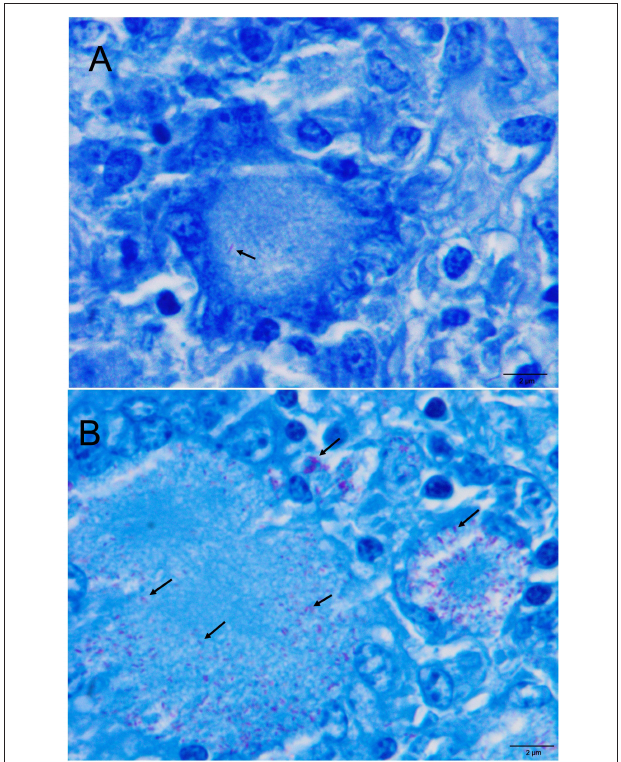
FIGURE 3 | (A) Retropharyngeal LN. Paucibacillary lesion. The arrowhead shows acid fast bacilli (AFB) within cytoplasm of a Langhans-type MNGCs (Ziehl-Neelsen, ZN) (B) . Mesenteric LN. Pluribacillary lesion. Numerous AFB within the cytoplasm of Langhans-type MNGCs and epithelioid cells (ZN).